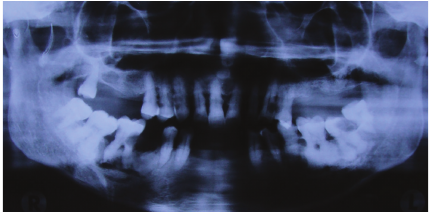
Figure 2: Extraoral imaging: conventional orthopantomogram confirming the presence of bulbous roots with irregular outline, bilaterally seen in the second premolars and first and second molars and revealing multiple missing teeth with generalized interdental bone loss.